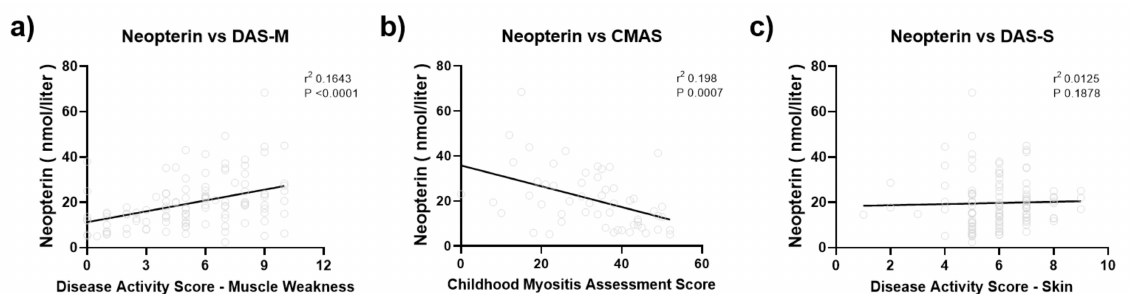
Figure 4. Correlation between serum neopterin level and clinical disease activity markers. ( a ) There was a correlation between the serum neopterin level and muscle weakness disease activity score (mDAS) (r 2 = 0.16, P < 0.0001) and ( b ) Childhood Myositis Assessment Scalee (CMAS) (r 2 = 0.2,